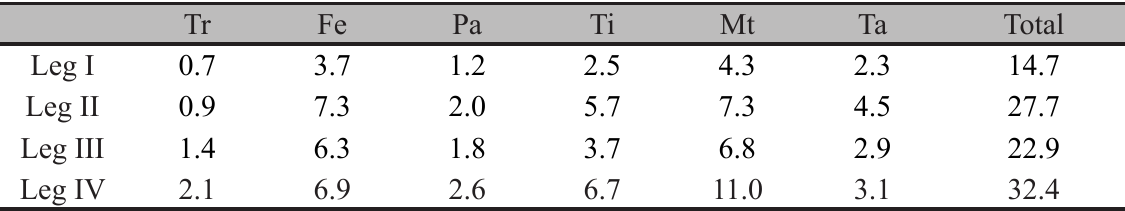
Table 3. Leg measurements (in mm) of Amazochroma carvalhoi (Mello-Leitão, 1941) comb. nov., ♂, holotype (MNRJ 5143).